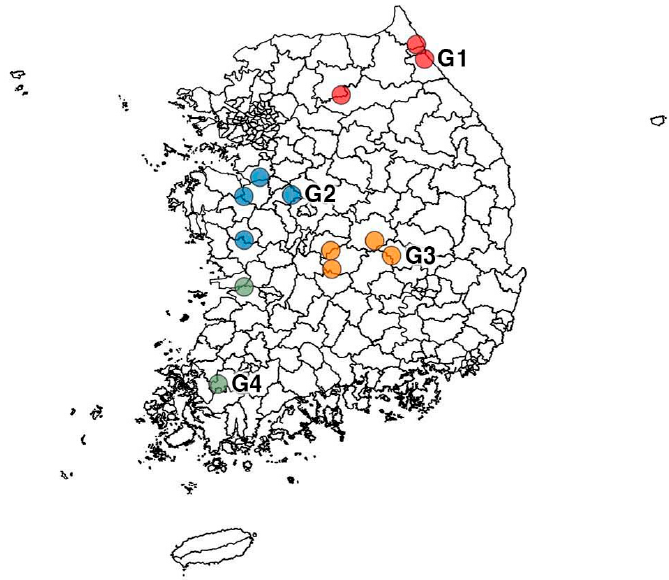
Figure 1. Experimental areas (G1, G2, G3, and G4) used in this